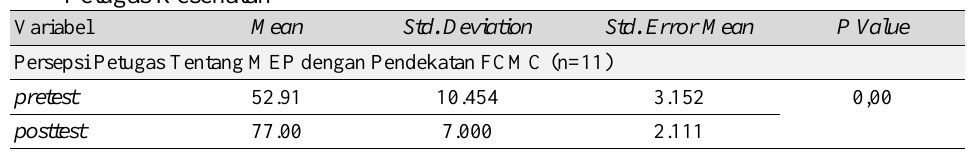
Pengaruh Sosialisasi Edukasi Postnatal Dengan Pendekatan FCMC Terhadap